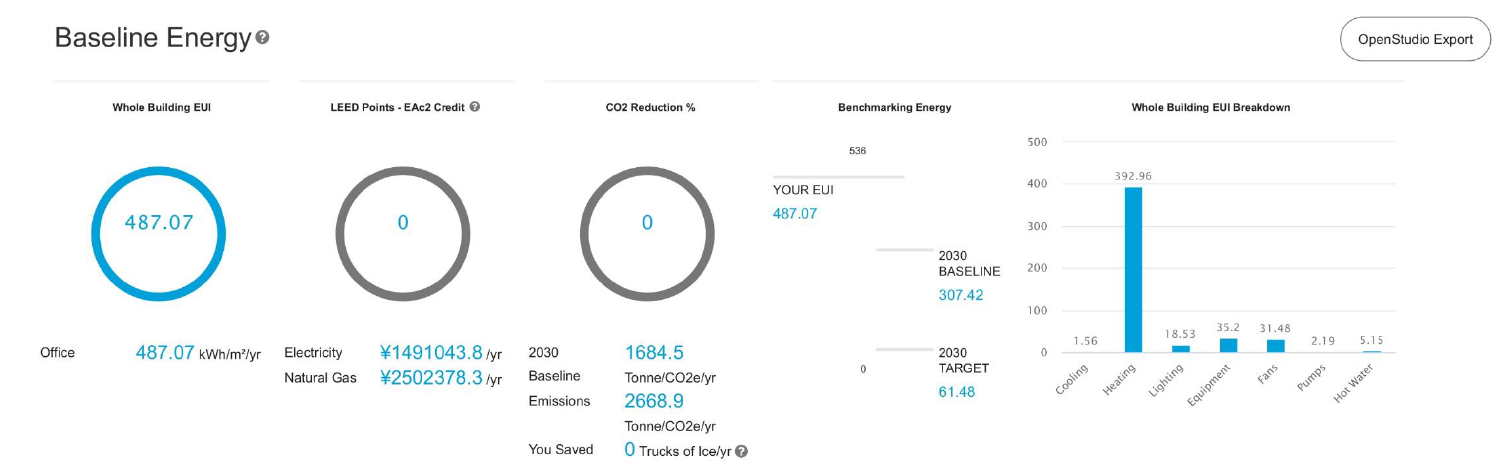
Figure A34. Zone 6-B Ordos, Nei Menggu (pre-COVID-19 scenario).